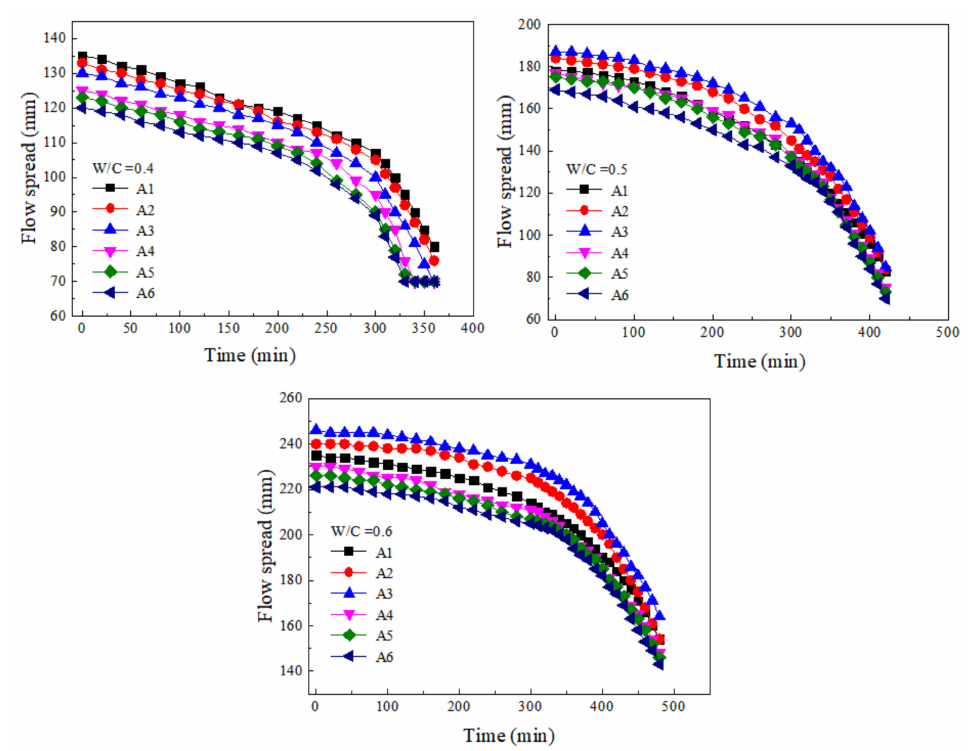
Figure 8. Variations of flow spread at different w/c ratios and SF substitute contents with time.